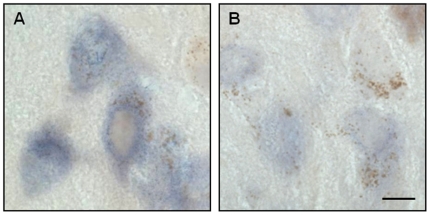
α-Synuclein siRNA decreases α-synuclein mRNA within pigmented nigral neurons.siRNA against α-synuclein was infused into the left substantia nigra of squirrel monkeys. Right (A) and left (B) midbrain sections at the level of the exit of the 3rd nerve were used for α-synuclein in situ hybridization. Representative images show nigral dopaminergic neurons containing neuromelanin (brown granules). The hybridization signal (purple) was markedly reduced in the left (siRNA-infused) as compared to the right (untreated) hemisphere. Scale bar = 10 µm.